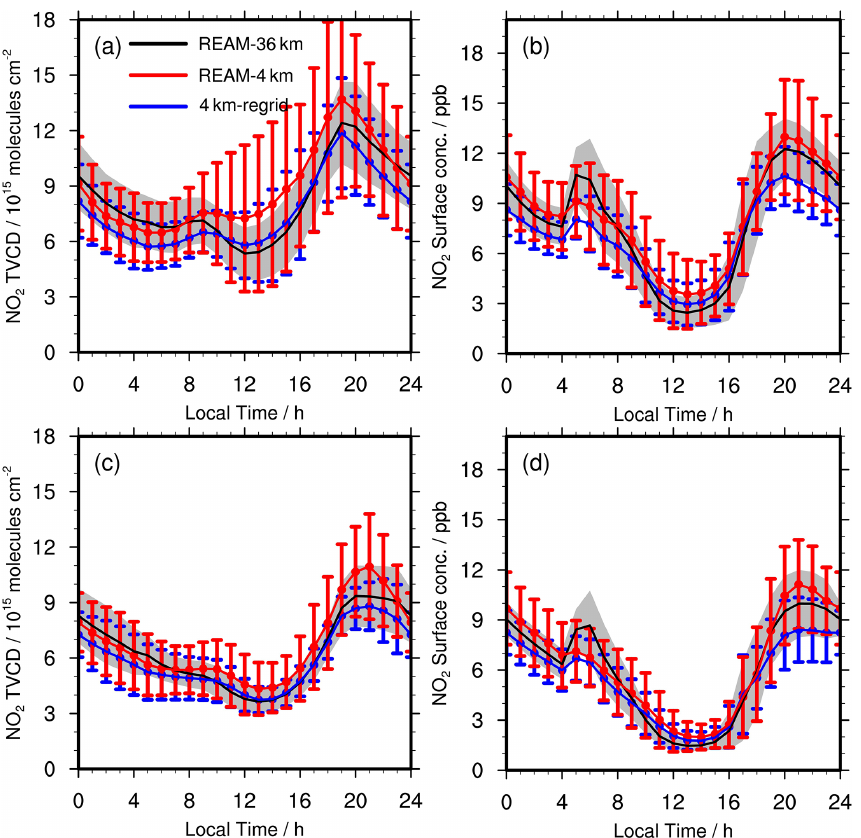
Figure 13. Comparisons of NO 2 (a, c) TVCDs and (b, d) surface concentrations over the 11 inland Pandora sites between the 4 and 36km REAM simulations on (a, b) weekdays and (c, d) weekends for July 2011. “REAM-36km” (black lines) denotes the 36km REAM simulation results; “REAM-4km” (red lines) denotes the 4km REAM simulation results; “4km-regrid” (blue lines) refers to the 36km values by regridding the 4km REAM simulation results into 36km REAM grid cells. The vertical bars denote corresponding standard deviations for all data except the 36km REAM simulation results, the standard deviations of which are shown with gray